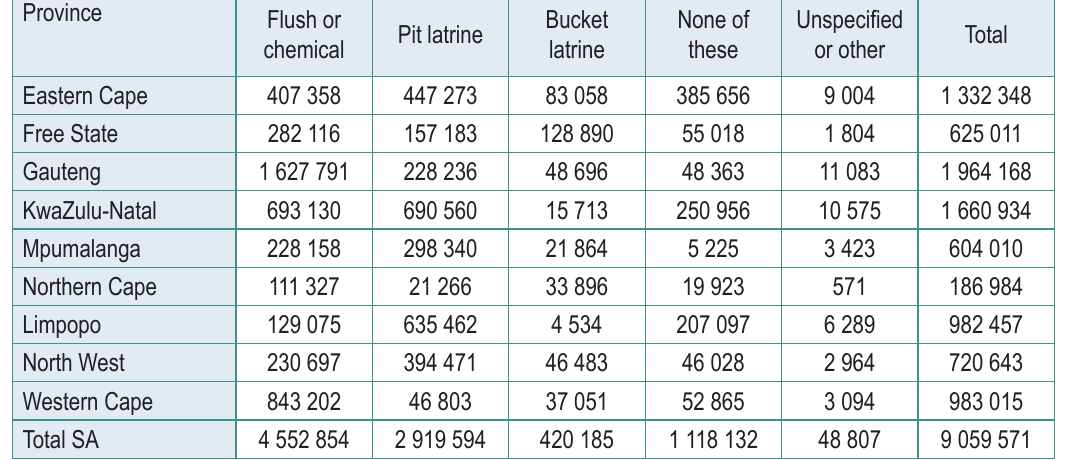
Table 3: Toilet facilities by province, 1996 (number of households)